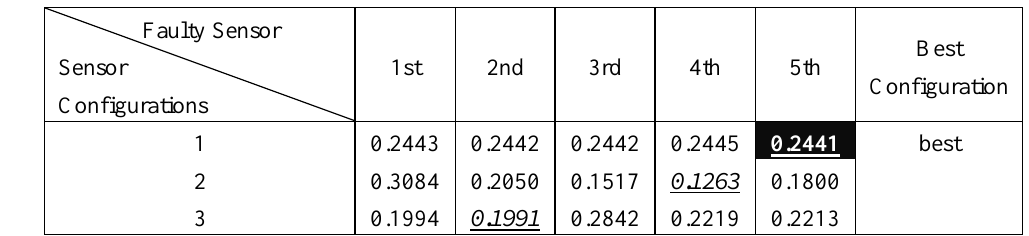
Table 8. PCI for each faulty sensor with